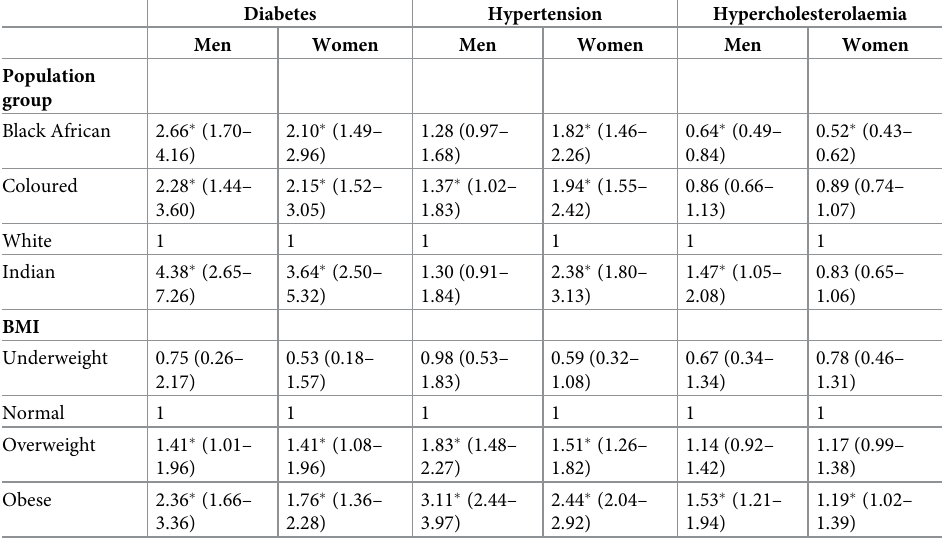
Table 3. Adjusted logistic regression models for association of diabetes, hypertension and hypercholesterolaemia with population groups and body mass index by